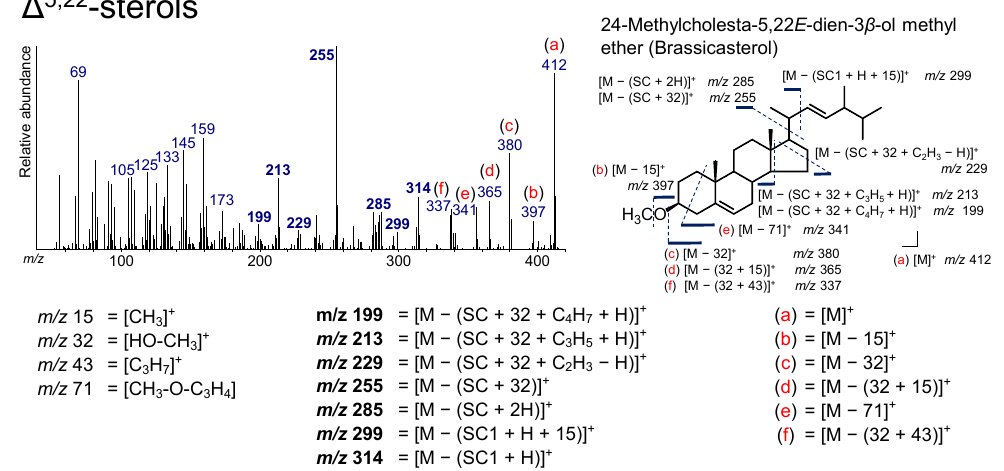
Figure 8. Electron ionization mass spectrum of 24-methylcholesta-5,22 E -dien-3 β -ol methyl ether (brassicasterol). Bold numbers indicate an ion accompanying the cleavage of the side chain. ( a )–( f ) Ions that are not accompanied by the loss of the side chain or other